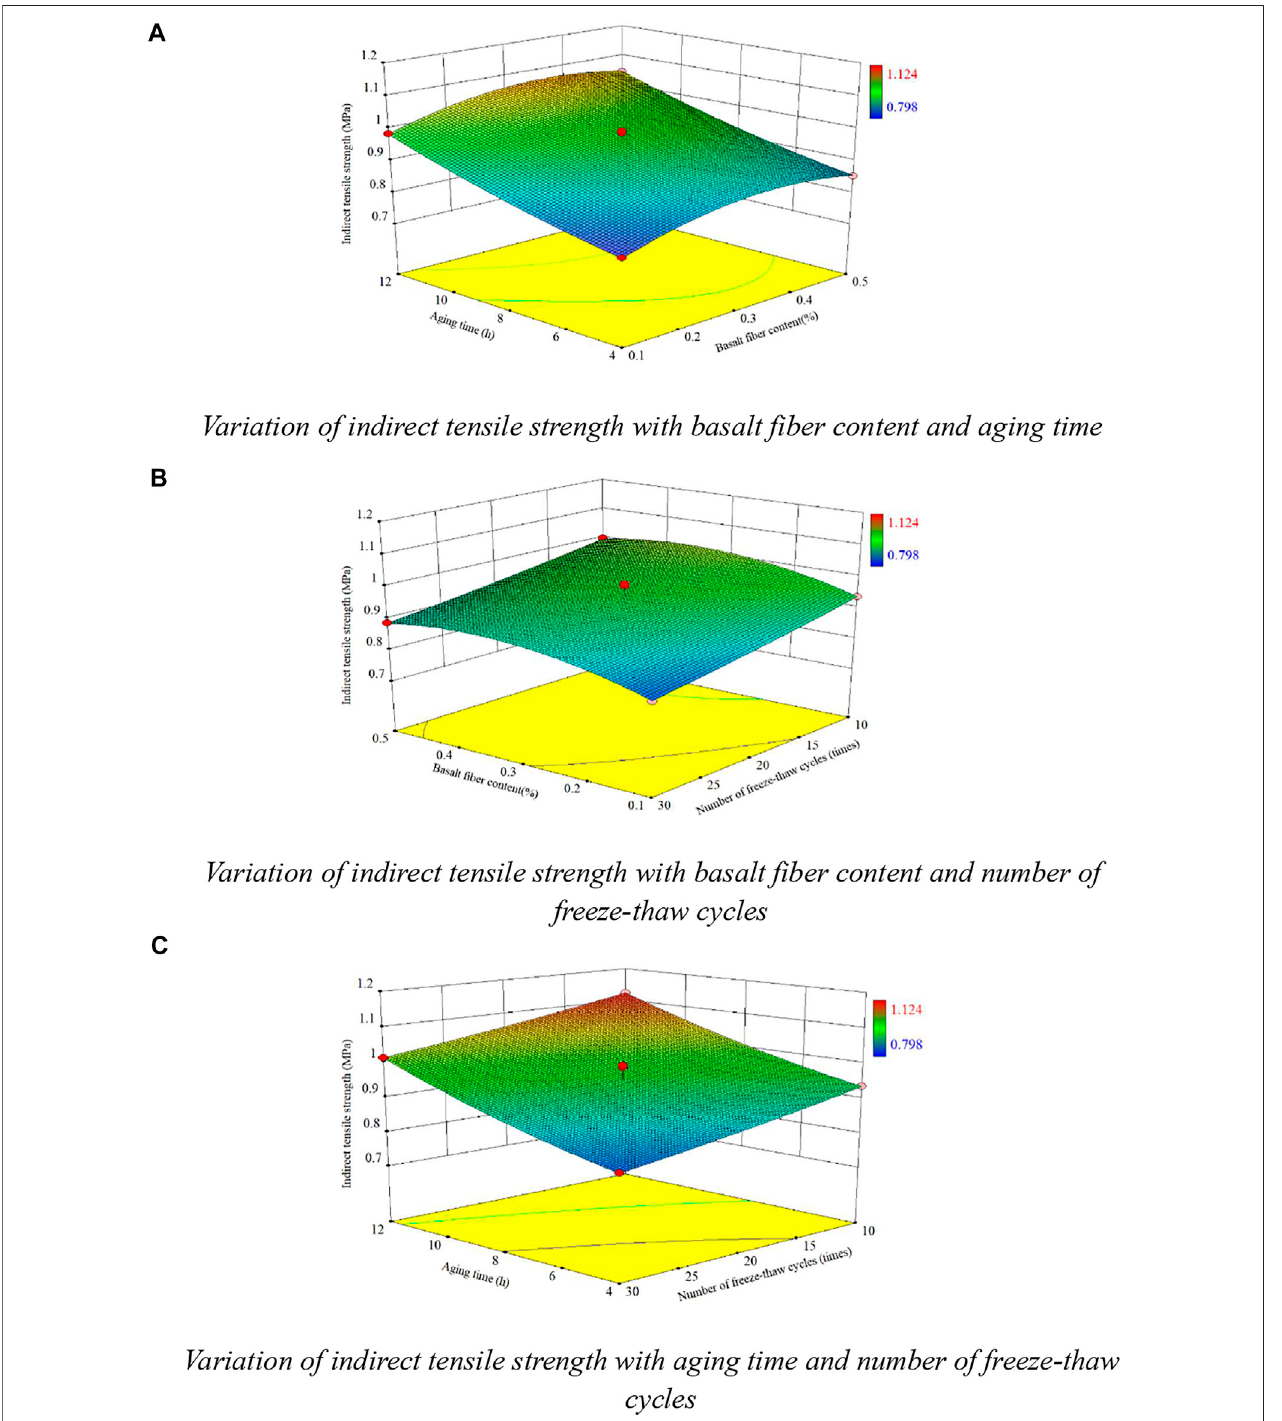
FIGURE 7 | Indirect tensile test results. (A) Variation of indirect tensile strength with the basalt fi ber content and aging time. (B) Variation of indirect tensile strength with the basalt fi ber content and number of freeze-thaw cycles. (C) Variation of indirect tensile strength with aging time and the number of freeze-thaw cycles